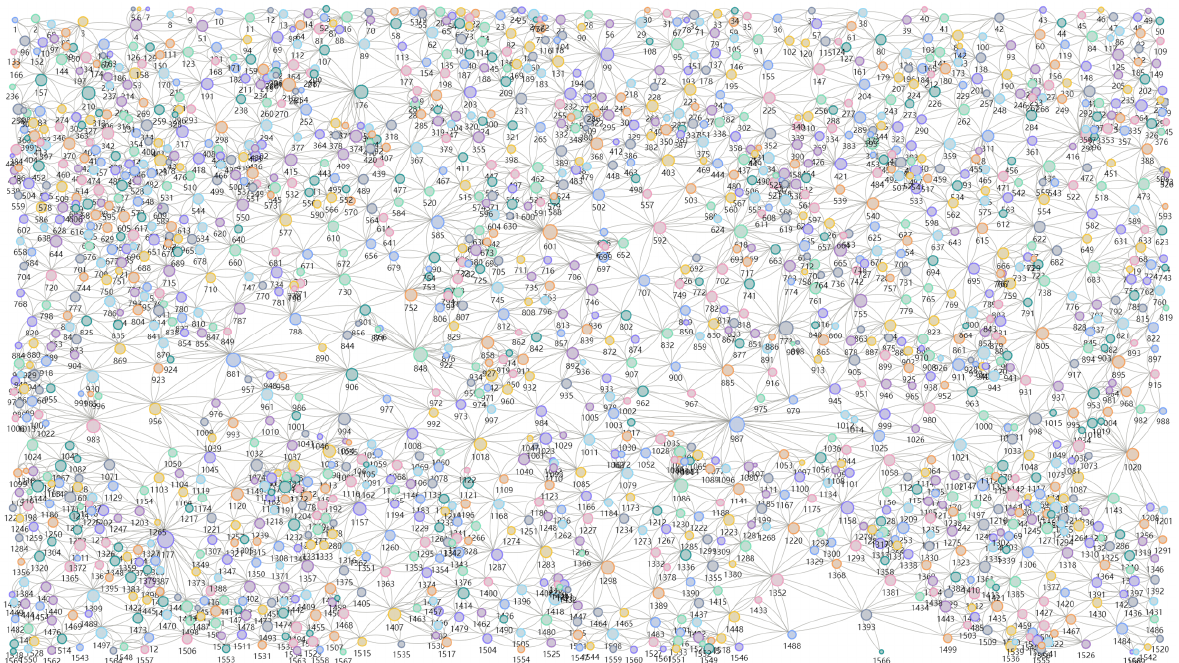
Figure 1. Grain knowledge graph. Each node in the figure represents a crystal grain in the microstructure, and the edges between nodes represent the grain boundaries between the original crystal grains.